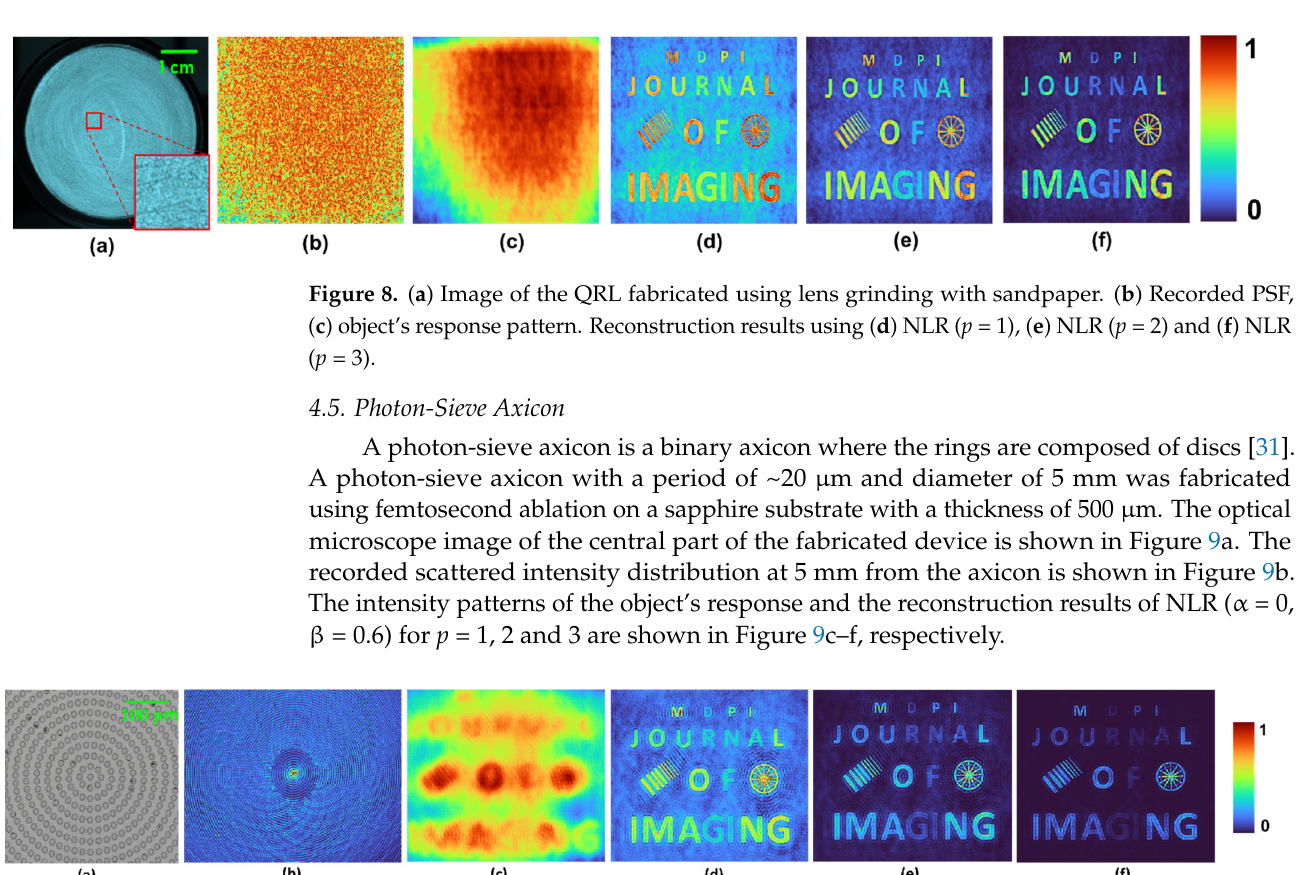
Figure 8. ( a ) Image of the QRL fabricated using lens grinding with sandpaper. ( b ) Recorded PSF, ( c ) object’s response pattern. Reconstruction results using ( d ) NLR ( p = 1), ( e ) NLR ( p = 2) and ( f ) NLR ( p = 3).